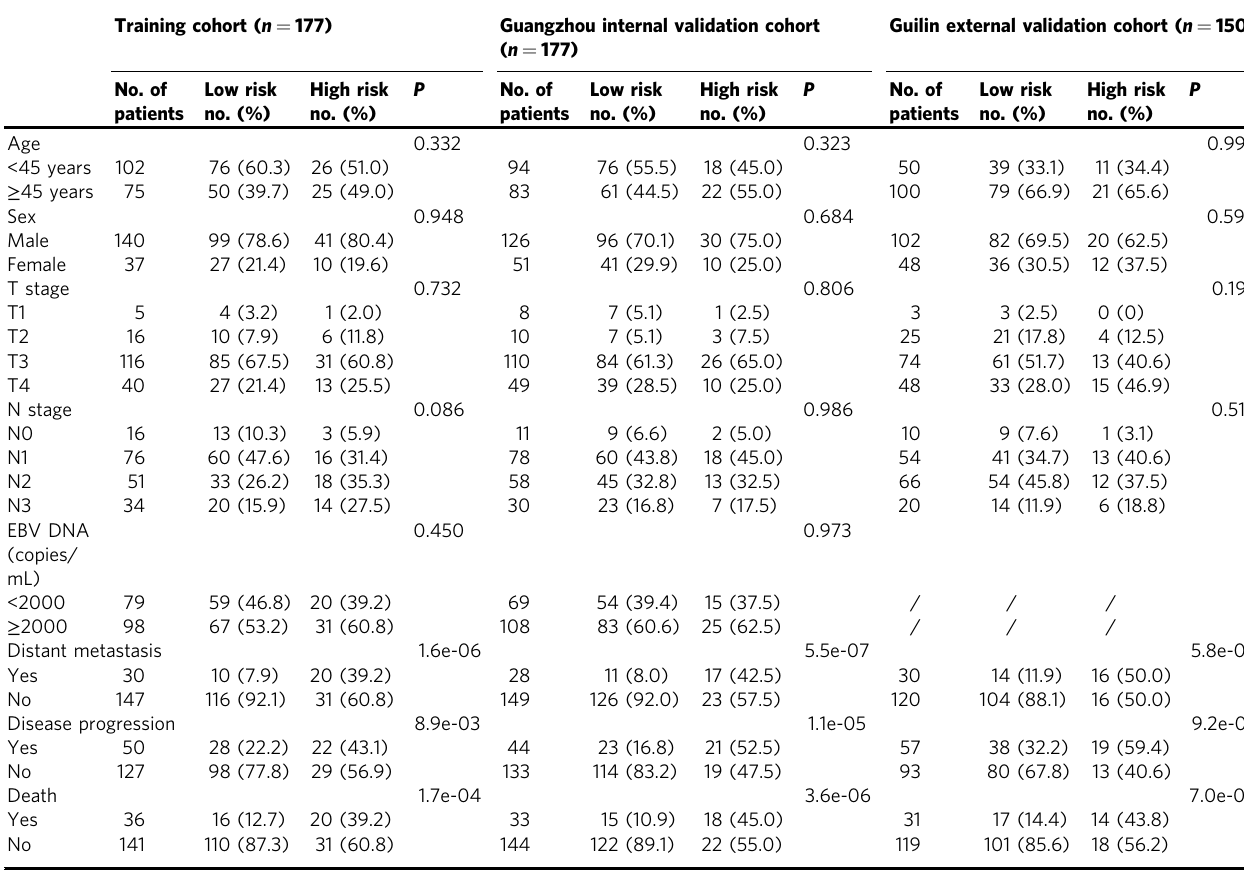
Table 1 Patient characteristics in the training, internal and external validation cohorts strati fi ed according to the immune-related lncRNA